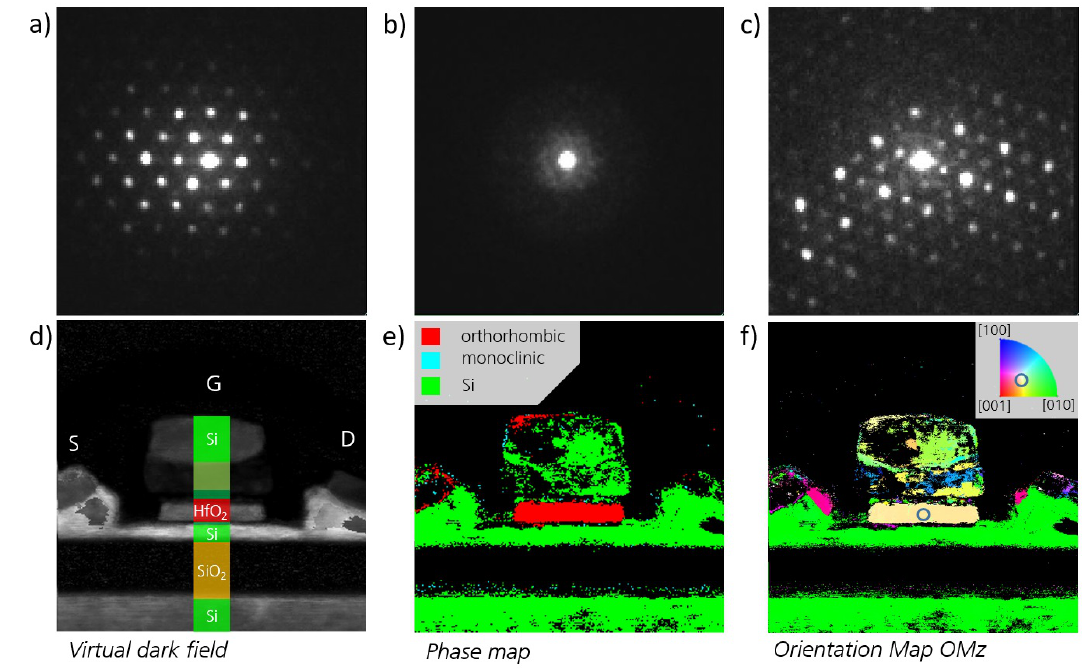
Figure 6. ( a – c ) display the measured diffraction pattern for measurement points from the silicon, silicon oxide, and hafnium oxide region, respectively; ( d ) shows the dark field of the cross-section of a 22 nm FDSOI FeFET. The phase map is shown in ( e ), showing predominantly orthorhombic HfO 2 . The crystallographic axis parallel to the gate stack is visualized in ( f ) indicating an orientation close to